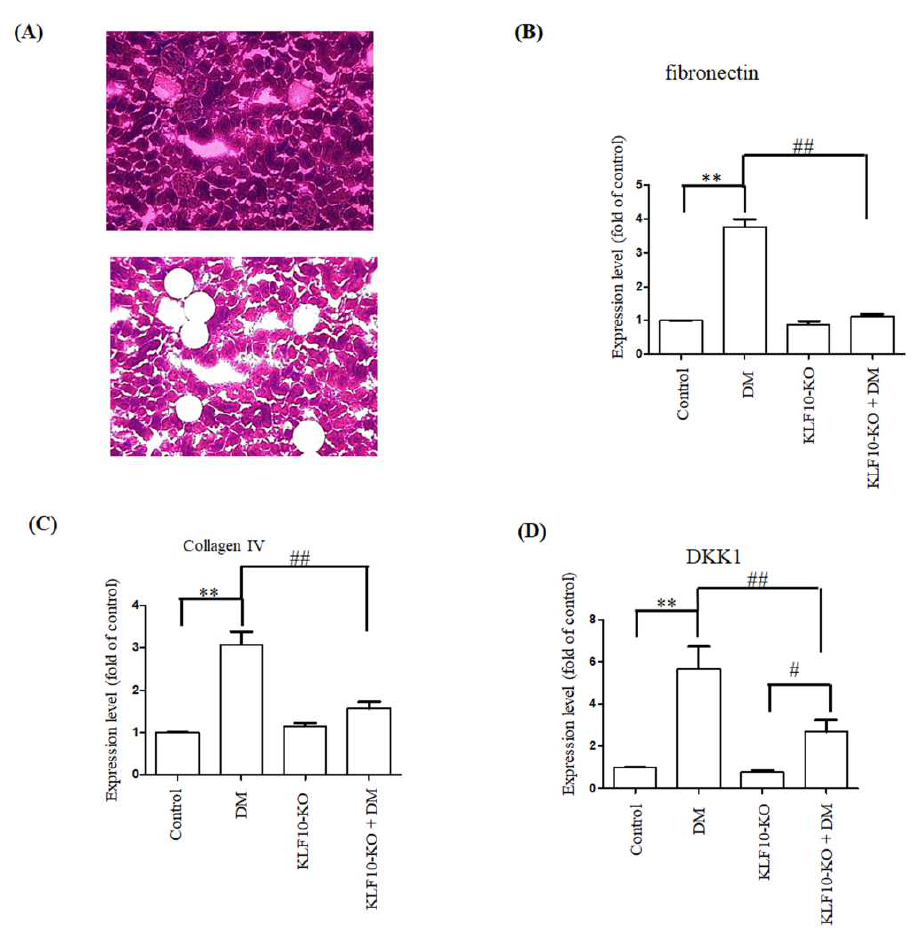
Figure 4. Repression of fibrosis-related gene expression in KLF10 knockout diabetic mice. ( A ) Images at × 100 magnification obtained before (upper panel) and after (lower panel) LCM capture. Total RNA extracted from glomerular mesangium derived from control or KLF10 knockout mice with or without diabetes (DM) were subjected to quantitative RT-PCR analysis of ( B ) fibronectin, ( C ) type IV collagen, and ( D ) DKK-1. Data are presented as means ± standard deviation obtained from at least three independent experiments. **: p < 0.01 compared with the control group. ##: p < 0.01 compared with the DM group. #: p < 0.05 compared to KLF10-KO group.